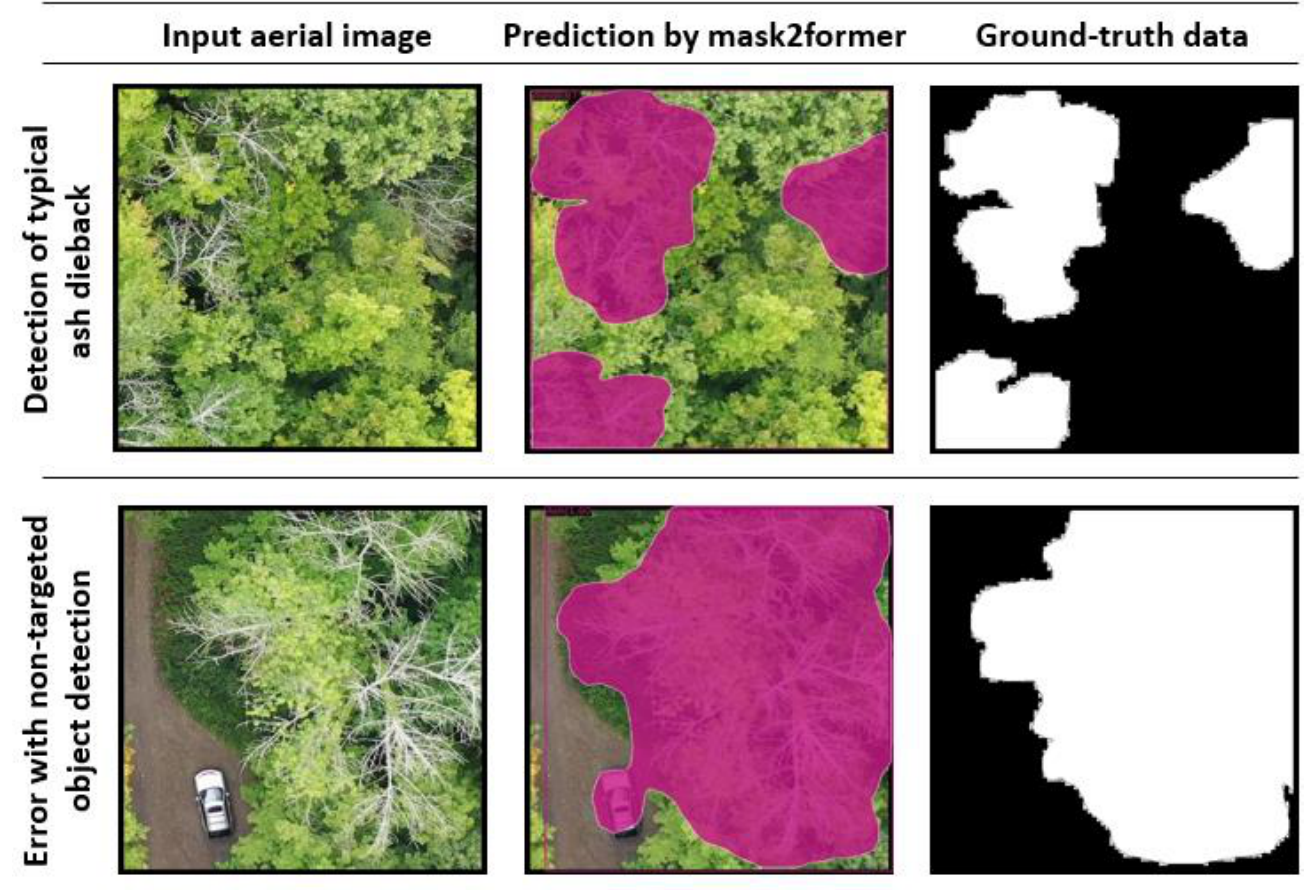
Figure 3. Two examples of Mask2former’s predictions of declining or dead ash trees with a threshold of 0.75. Input aerial images were given to the model, and then the prediction was compared with the ground-truth data.